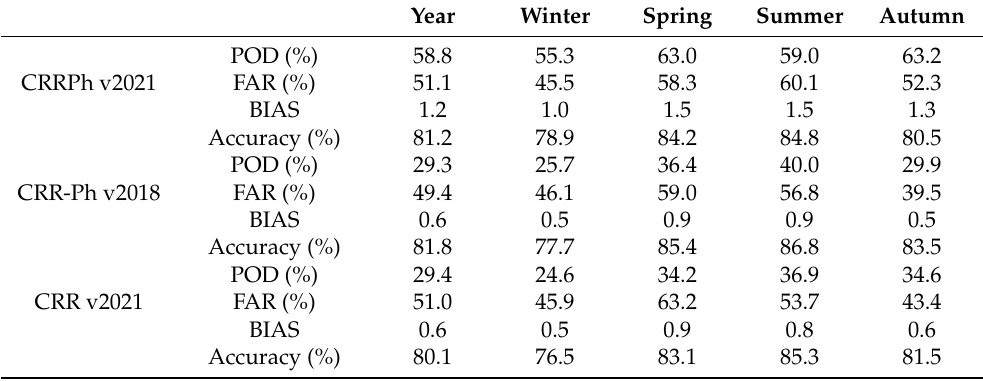
Table 4. Nighttime categorical statistics for CRRPh v2021, CRR-Ph v2018, and CRR